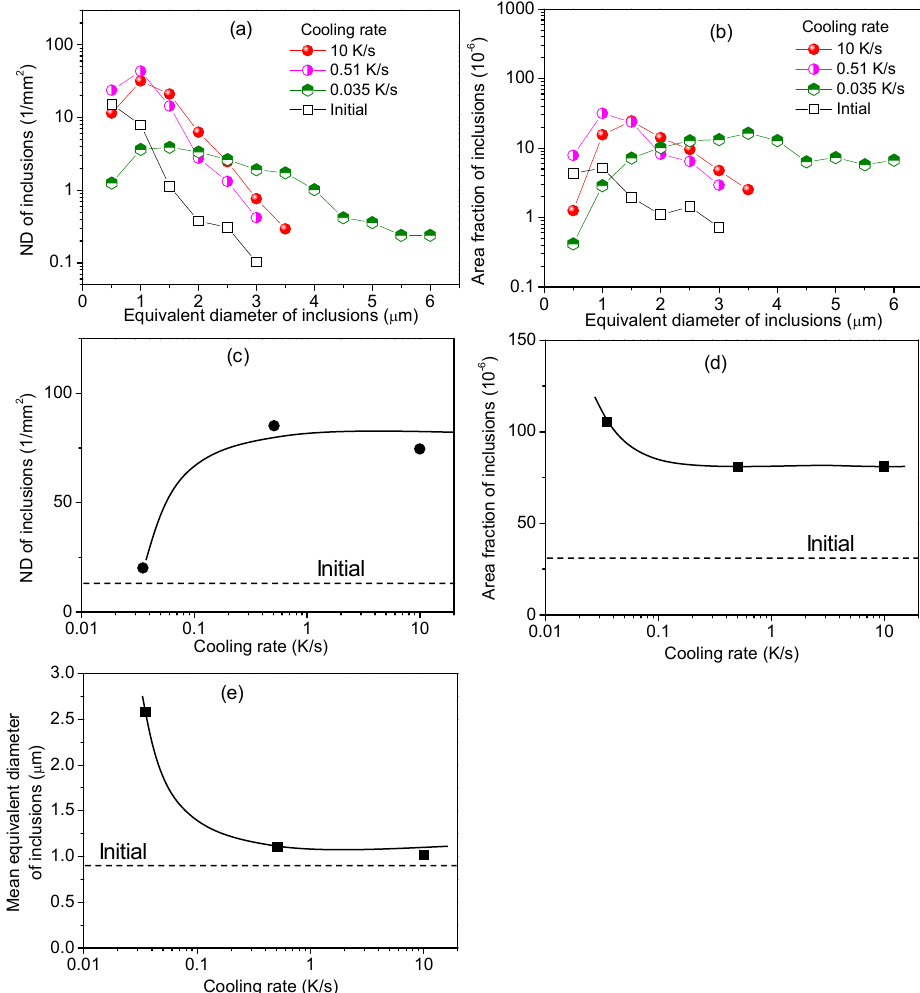
Figure 5. Variation in ( a ) number density and ( b ) area fraction of inclusions against its diameter under different cooling rates. The effects of cooling rate on the ( c ) number density, ( d ) area fraction and ( e ) mean equivalent diameter of the inclusions.